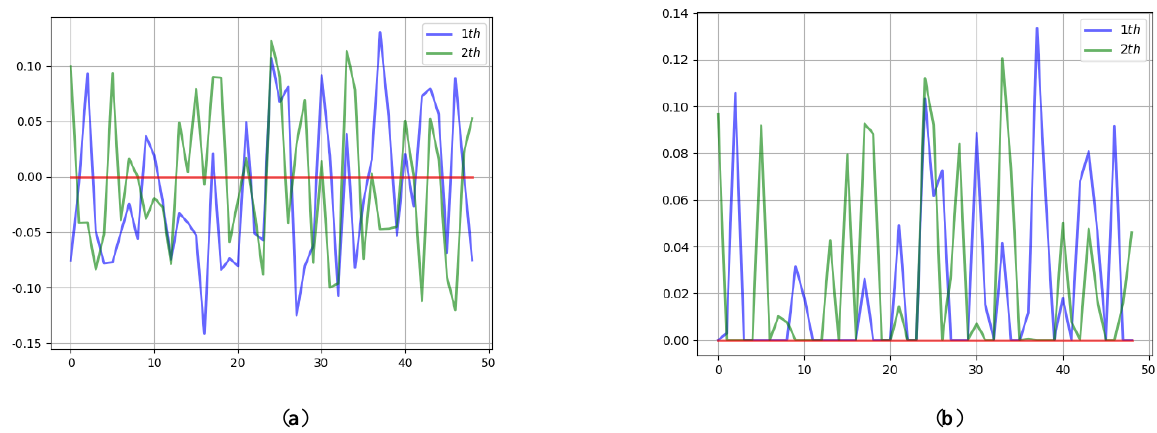
Figure 5. Results of the first two AFcaNet weights of the encoder. ( a ) Linear Layer Weight; ( b ) After ReLU Weight.